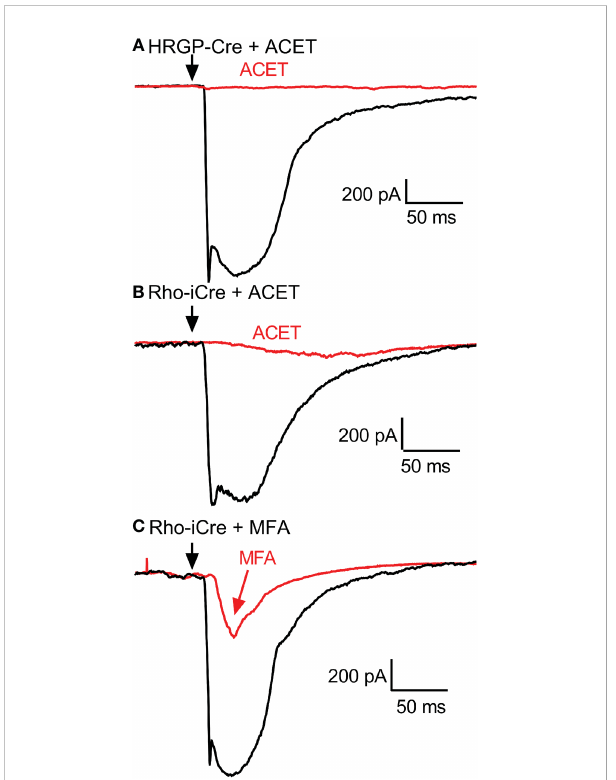
FIGURE 6 Example RGC response waveforms showing responses evoked by optogenetic stimulation of cones with and without ACET (A) , stimulation of rods with and without ACET (B) , and stimulation of rods with and without MFA (C) . Experiments in this fi gure were conducted in the presence of strychnine (1 m M) and picrotoxin (100 m